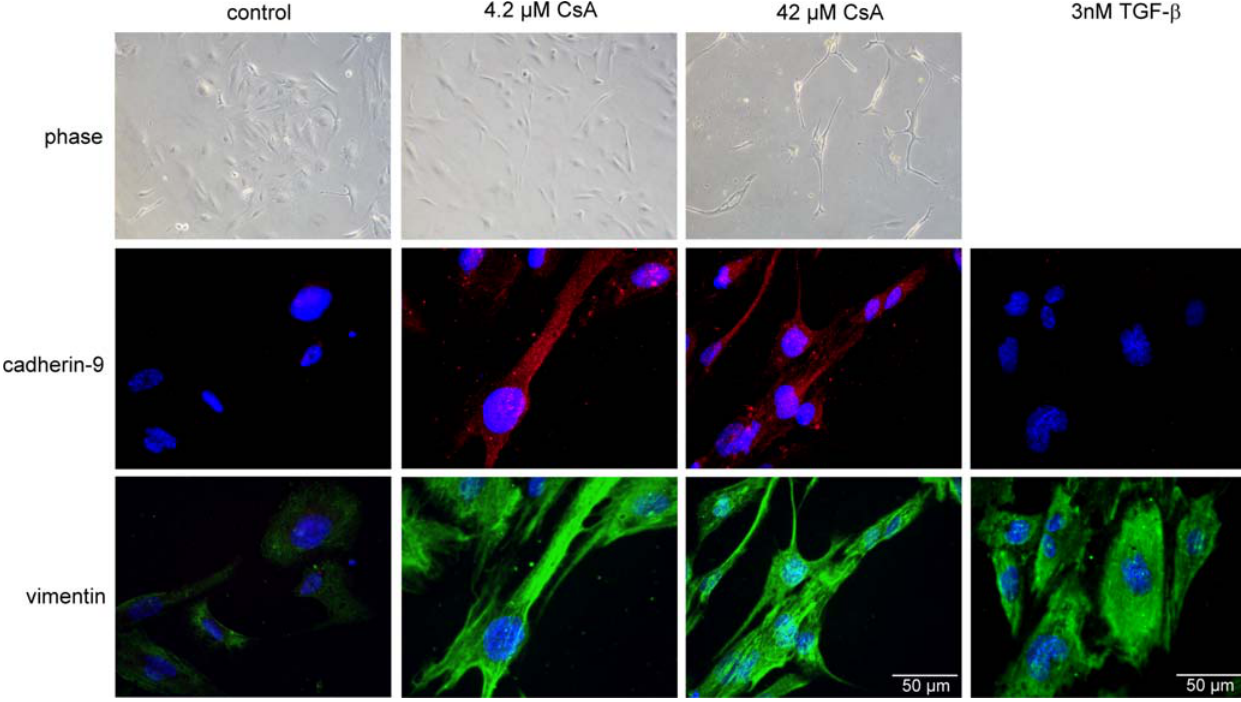
Figure 9. Up-regulation of cadherin-9 expression during cyclosporin-A induced EMT. To induce a transition of renal epithelial cells into a spindle- shaped mesenchymal cell type, the epithelial TK 163 cells were cultured for 48 hours in different concentrations (0, 4.2 and 42 m M) of cyclosporin-A (CsA). EMT could be observed by phase contrast microscopy. Immunofluorescence staining revealed that without CsA no signals for cadherin-9 and only weak signal for vimentin could be observed. Induction of EMT by CsA led to a strong up-regulation of both vimentin and cadherin-9 expression. In contrast, incubation of TK 163 cells with 3 nM TGF-ß for two days does not lead to an induction of cadherin-9 expression. Bar, 50 m m.